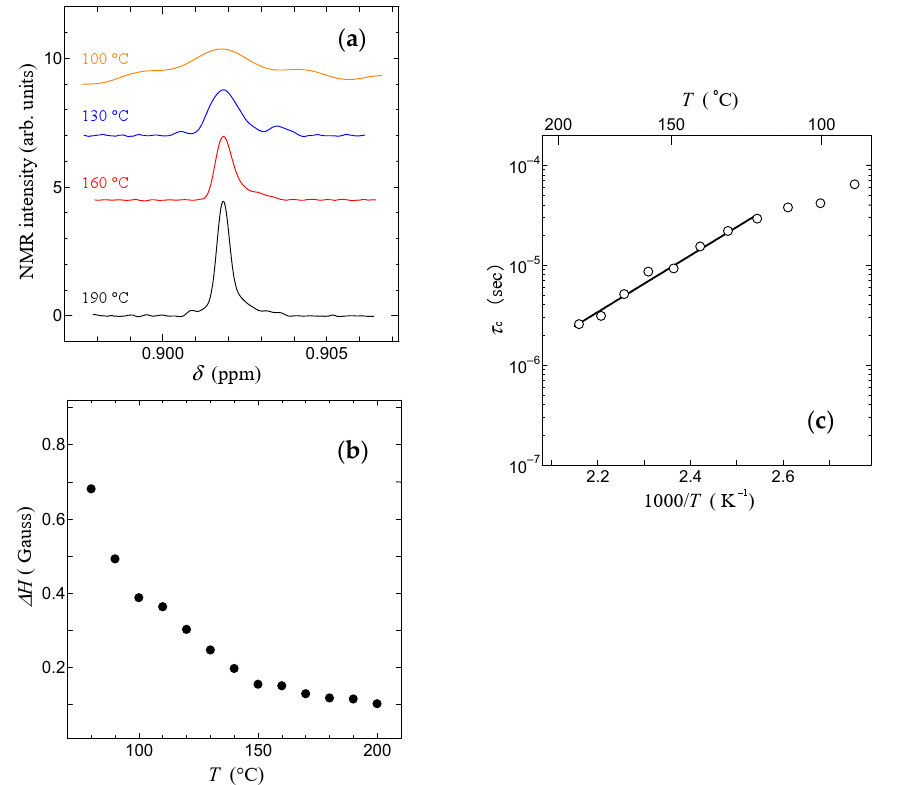
Figure 7. ( a ) NMR absorbance lines at various temperatures; ( b ) temperature dependence of ∆ H ; ( c ) temperature dependence of τ c .